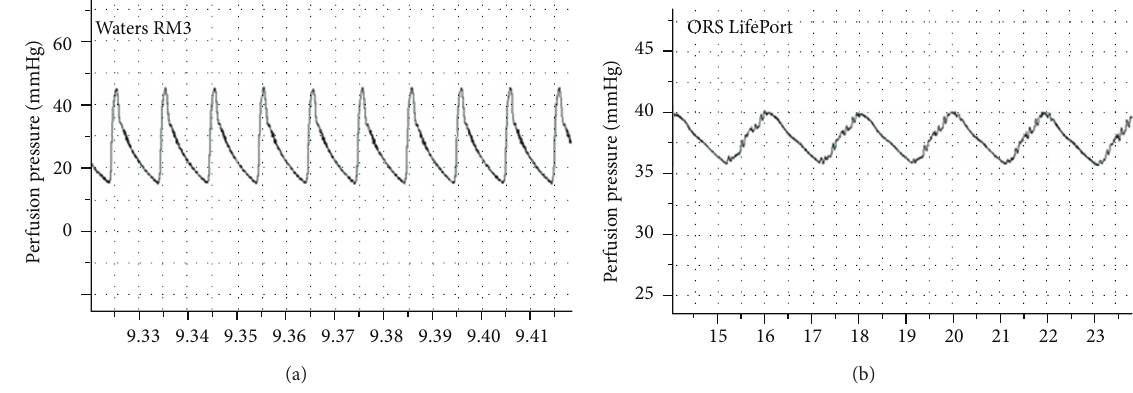
Figure 2: Samples of arterial pressure waveforms from a Waters RM3 and an ORS Lifeport during perfusion preservation.